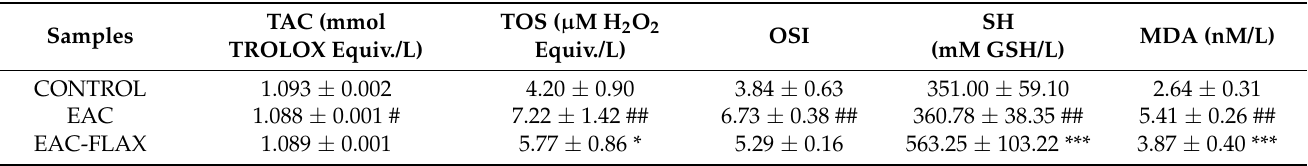
Table 4. Serum oxidative stress markers at the end of the experiment.